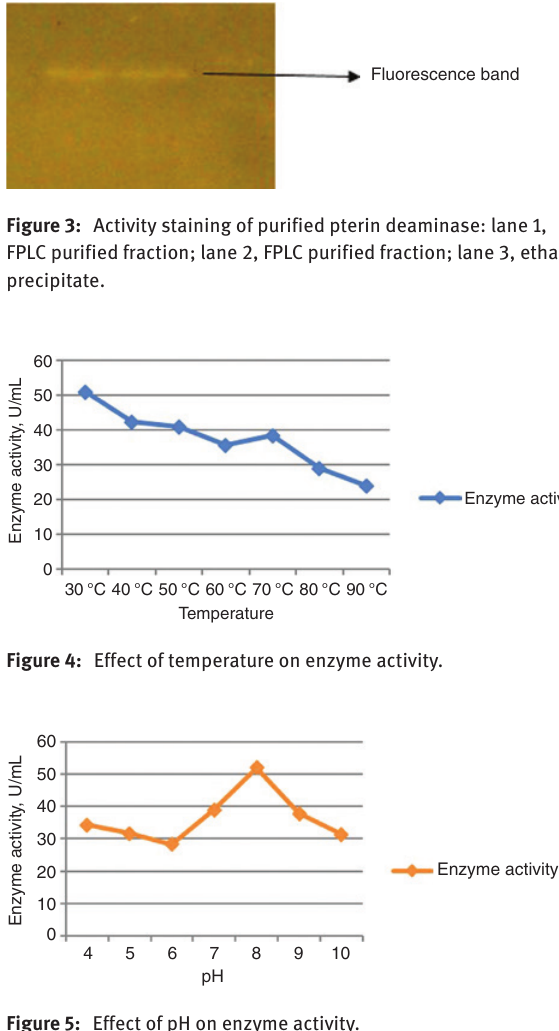
Figure 5: Effect of pH on enzyme activity.